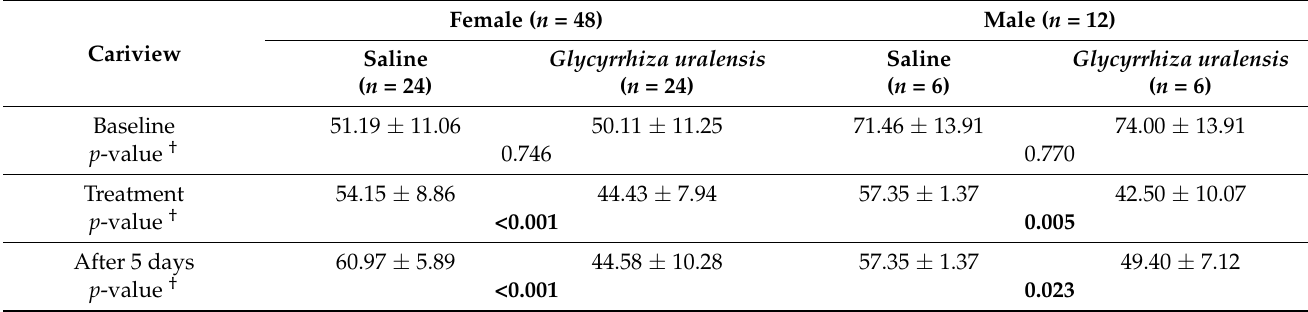
Table 5. Comparison of changes in the cariview according to gender ( n =